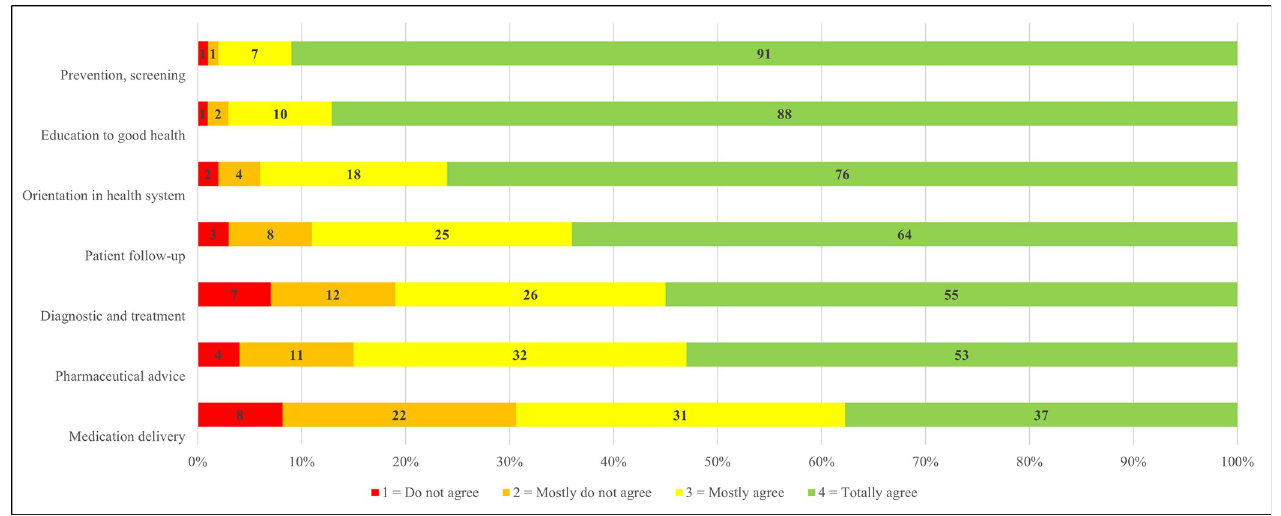
Fig 3. Functions associated with primary healthcare.